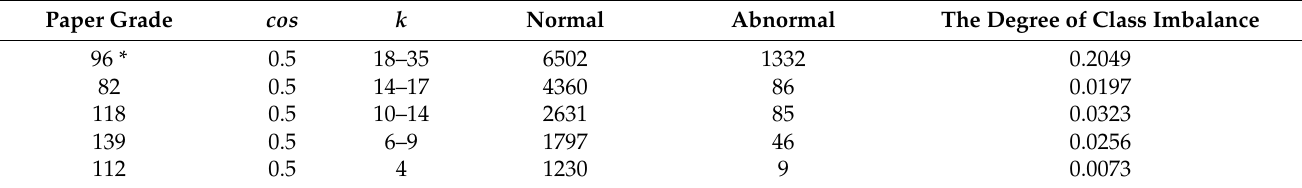
Table 3. The description of dataset after data